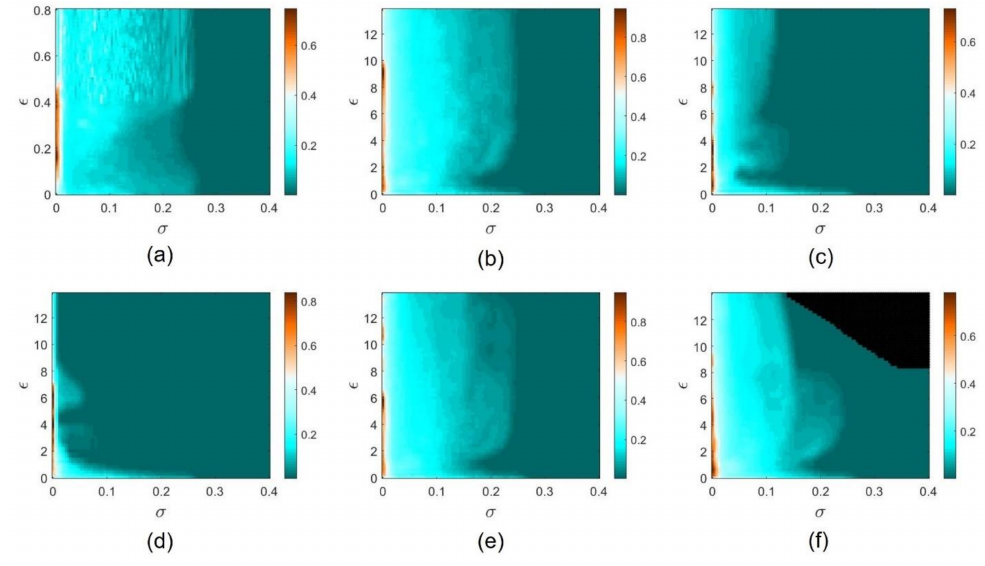
Figure 3. A 2D representation of the intralayer synchronization error ( E 1 ) in the ( σ , (cid:101) ) plane by considering different fractional-order derivatives for the layers: ( a ) q 1 = q 2 = 1; ( b ) q 1 = 1, q 2 = 0.9;